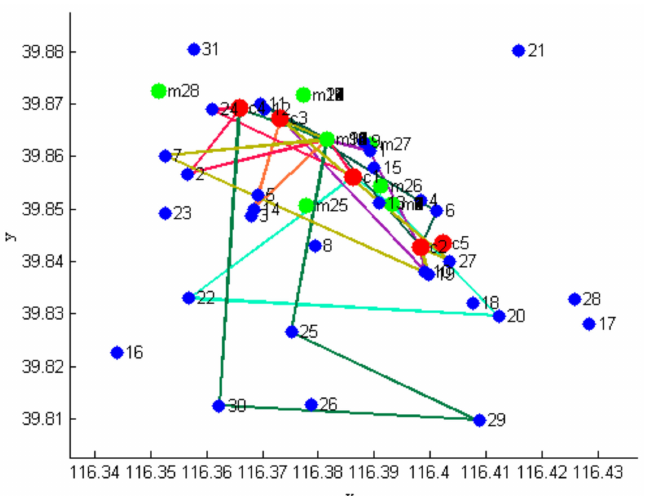
Figure 12. Distribution routes of deliverymen 1–7.